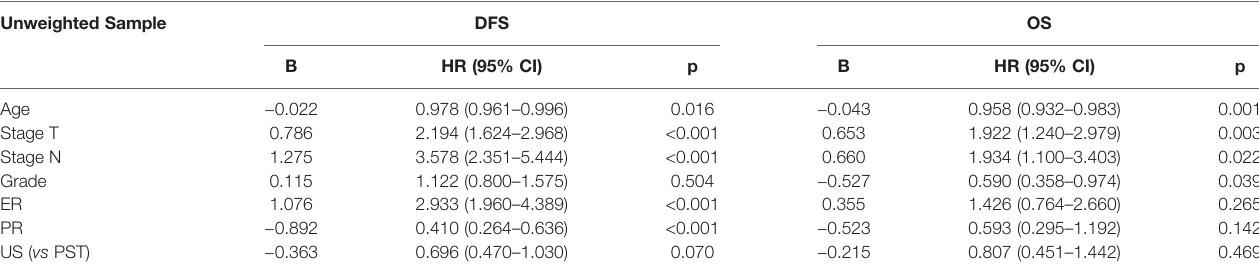
TABLE 2 | Multivariate analysis in Cox proportional hazards model. Unweighted